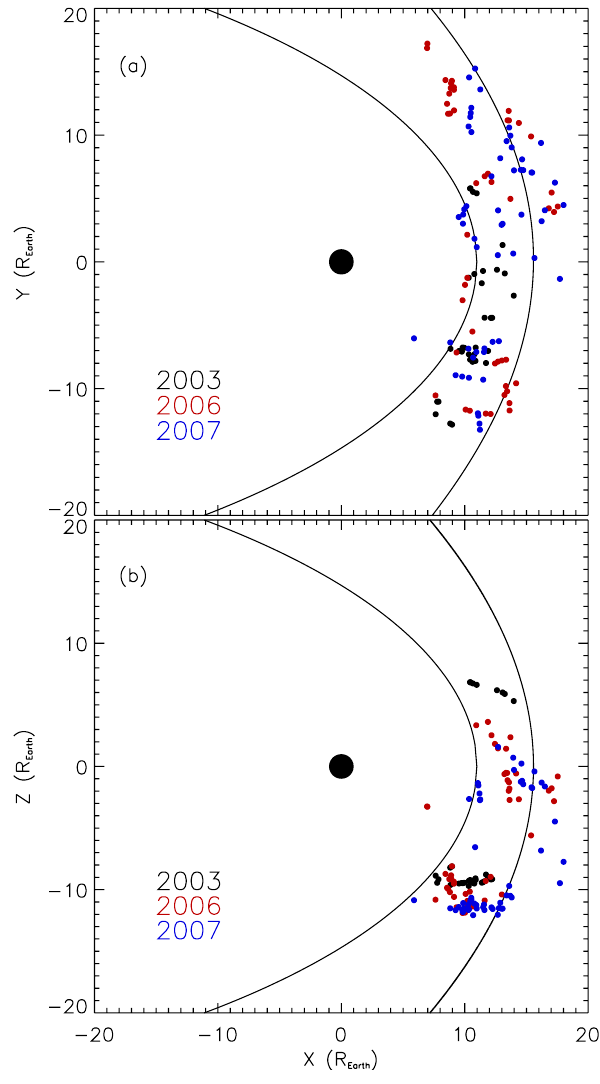
Fig. 1. HFA locations (a) in XY GSE and (b) XZ GSE plane pro- jections and the average bow shock and magnetopause positions. The coordinates were plotted in units of R Earth . The shapes of the magnetopause and the bow shock were calculated with the average solar wind pressure (Sibeck et al., 1991; Tsyganenko, 1995) and Alfv´en-Mach number during HFA formation (Peredo et al., 1995). The black, red and blue points show Cluster positions when HFAs were observed in 2003, 2006 and 2007,